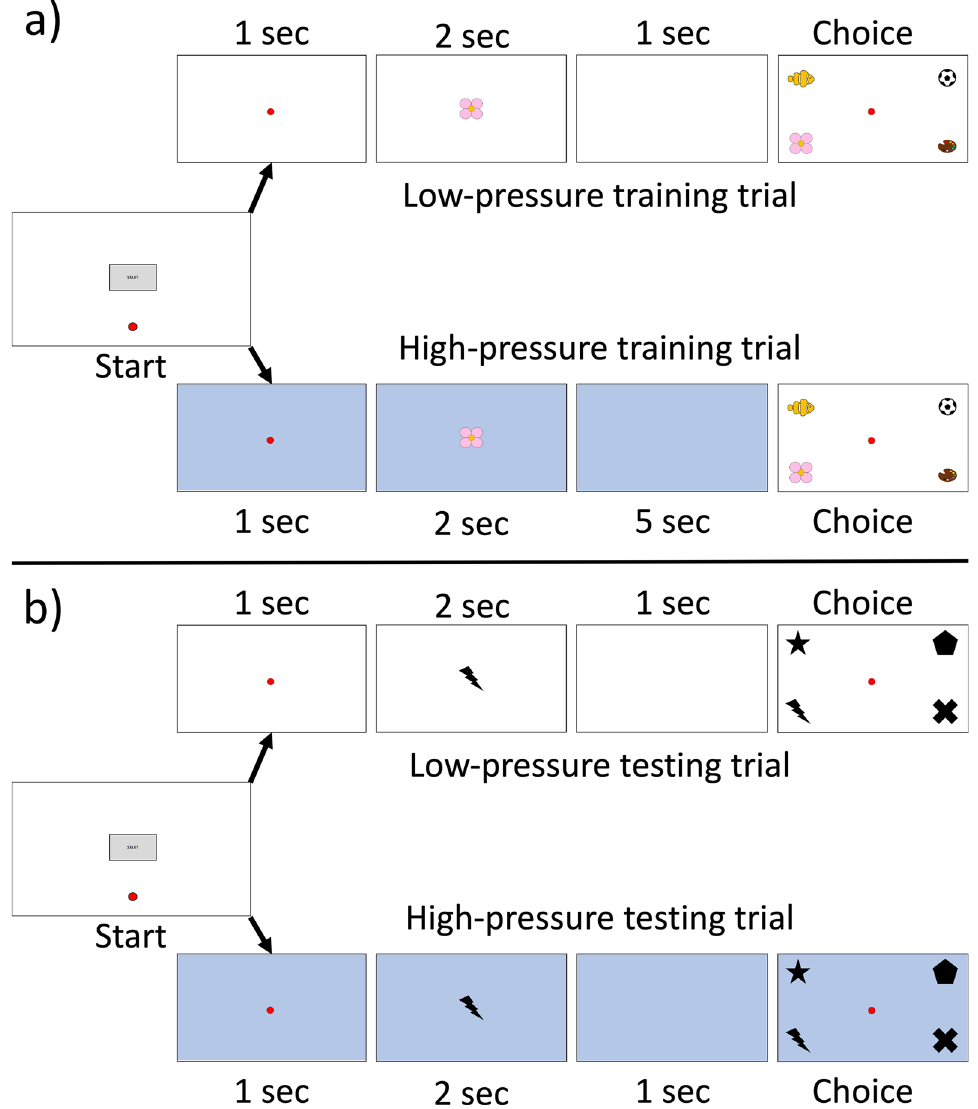
Figure 1. Side-by-side comparison of high-pressure and low-pressure trials in both training ( a ) and testing ( b ). While the trained background color cue occurs in the high-pressure test trial, all delays are the same as in the low-pressure test trial, removing any confounds of higher